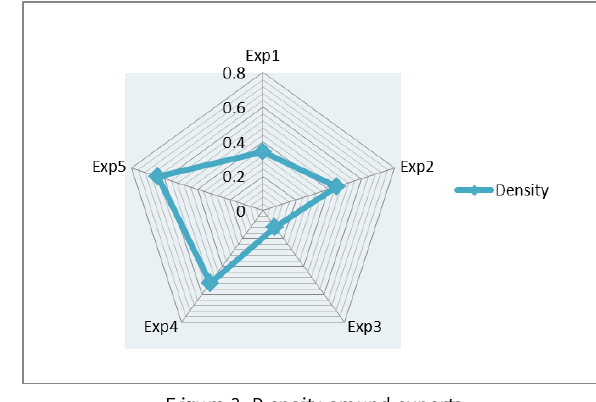
Figure 3. Density around